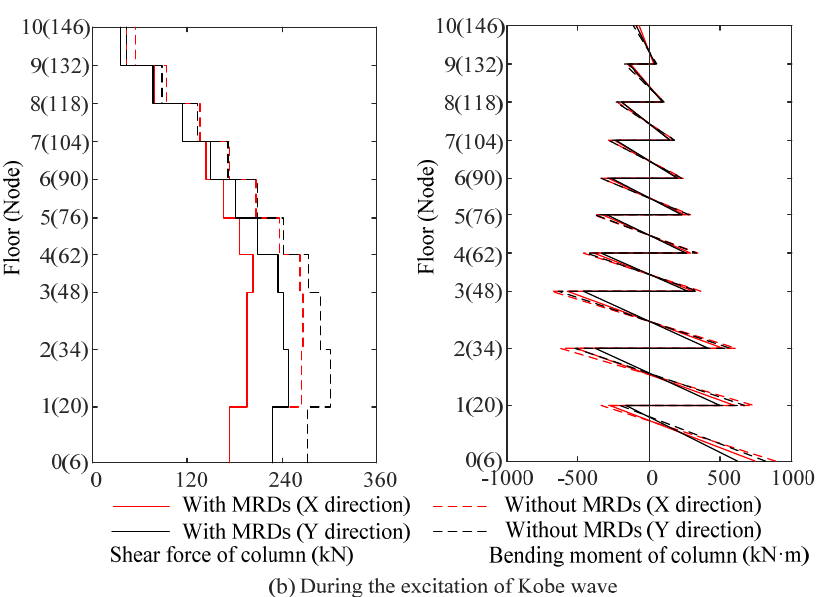
Figure 12. The max shear forces and bending moments of the columns of every floor of the structure with and without MRDs.